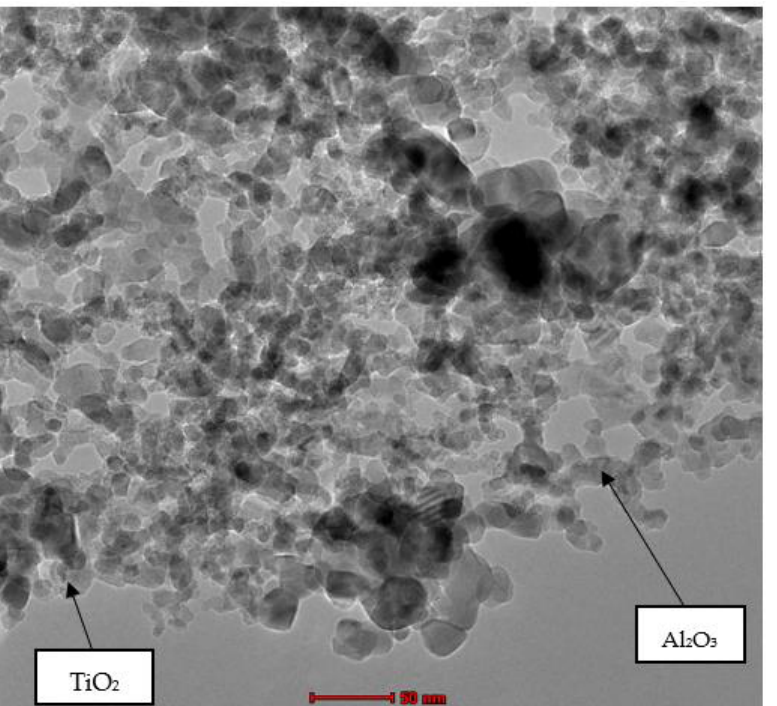
Figure 5. TEM image of Al 2 O 3 -TiO 2 nanoparticles.